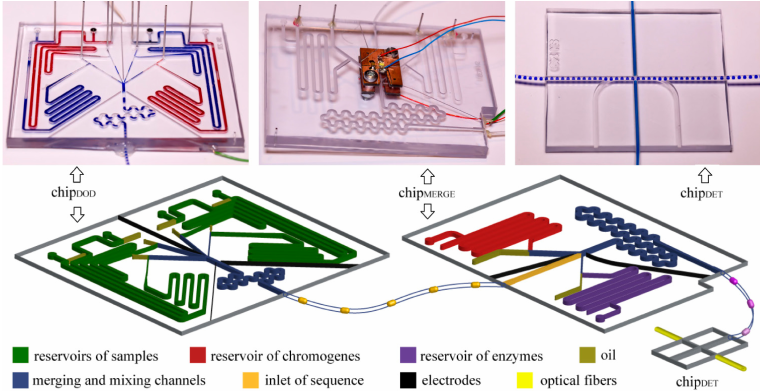
Figure 2. Photographs and schematic illustrations of the microfluidic chips. The whole system includes: (i) chip DOD used to generate droplets of predefined composition, (ii) polyethylene tubing used to store the droplets for incubation, (iii) chip MERGE used to merge post-fermentative droplets with droplets containing chromogenes and enzymes, and (iv) chip DET used to measure the concentration of ethanol in droplets.